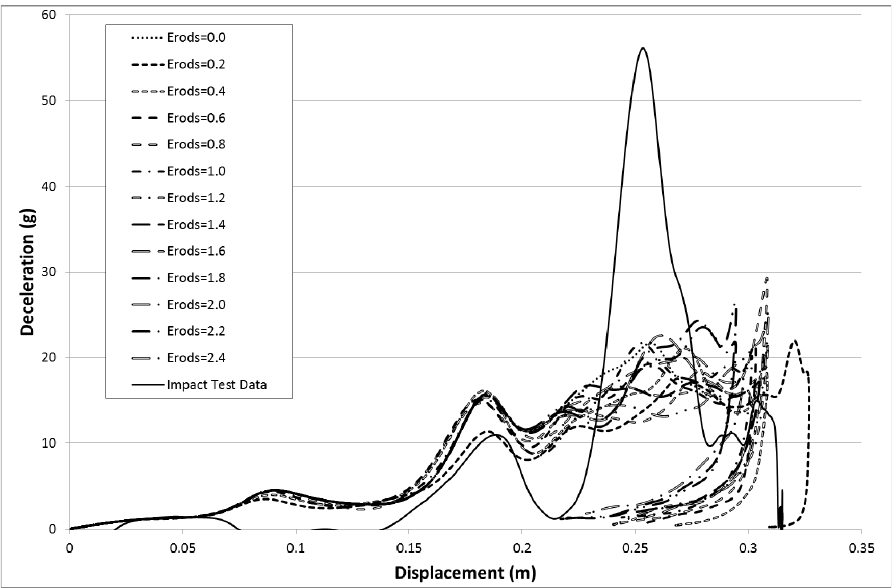
Figure 11. Effect of Erods parameter with All Slim = 1.0, TSize = 1 × 10 − 11 , Soft = 1.0 and FS = 1.0.